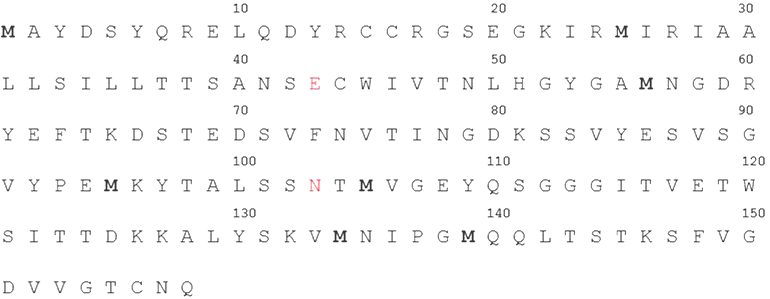
Figure 1. Schematic representation of the immunity region of bacteriophage 434. The N- and C-terminal domains of the cI repressor dimers are represented by black and gray circles, respectively bound to the operator sites. In above configuration shown, transcription of the promoters P activated on. The Hex gene is located on the same transcript initiated at P designated 1, 2, and 3 were used to analyze the P